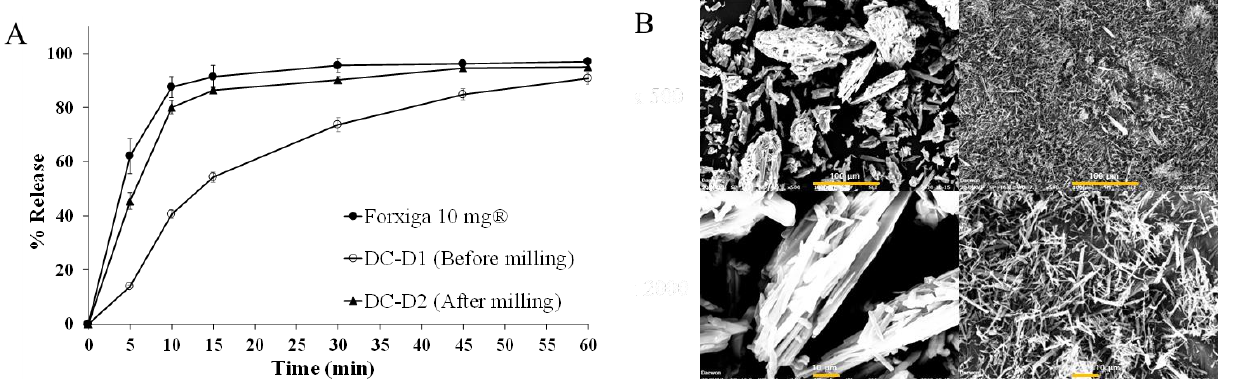
Figure 1. ( A ) Dissolution profiles of the DC-D1 tablet before and after milling of the dapagliflozin (DAP) cocrystal in pH 1.2. ( B ) SEM images of a DAP cocrystal before (left) and after (right) milling at two magnifications: 500 (top) and 2000 (bottom). Each value represents the mean ± standard deviation ( n =